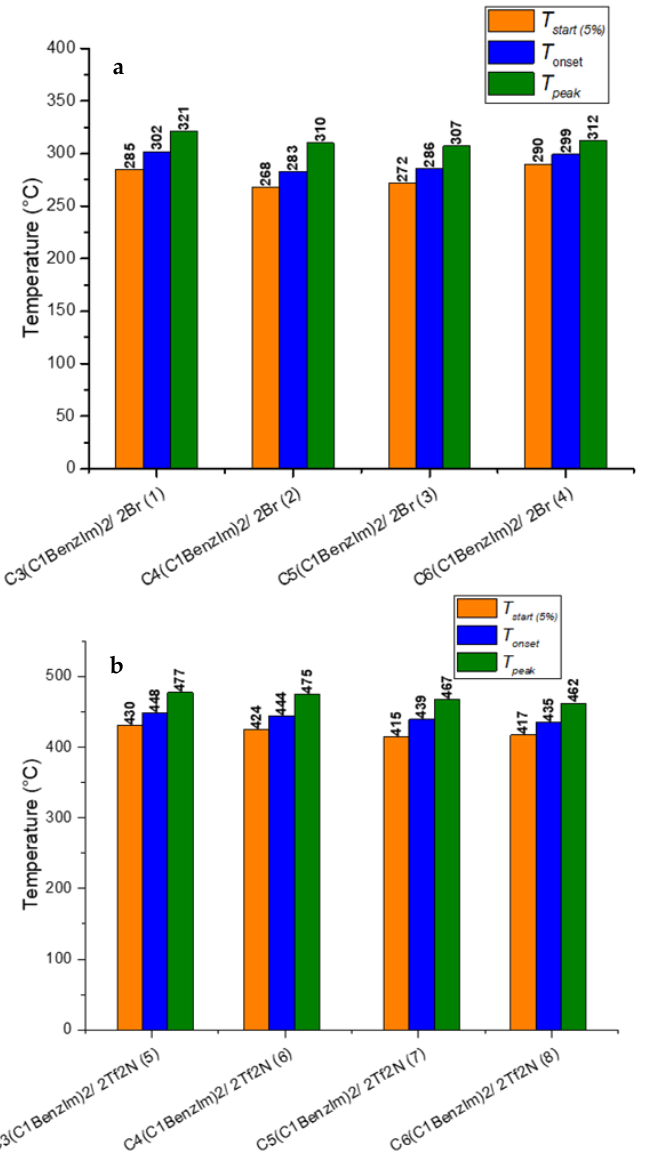
Figure 1. T start , T onset, and T peak for the bromide ( a ) and the bistriflimide ( b ) BDILs at a heating rate of 10 °C/min.